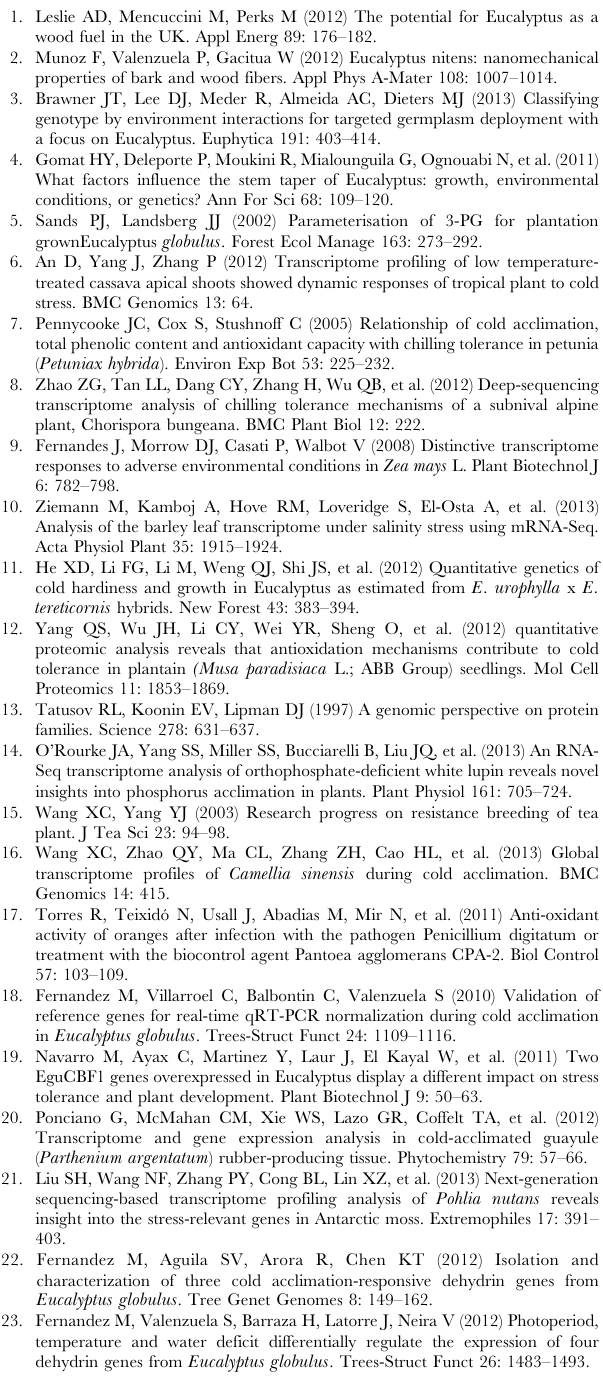
Table S7 Expression patterns of some transcripts involved in ’Response to cold’. Table S8 Expression patterns of some transcripts involved in ’translational